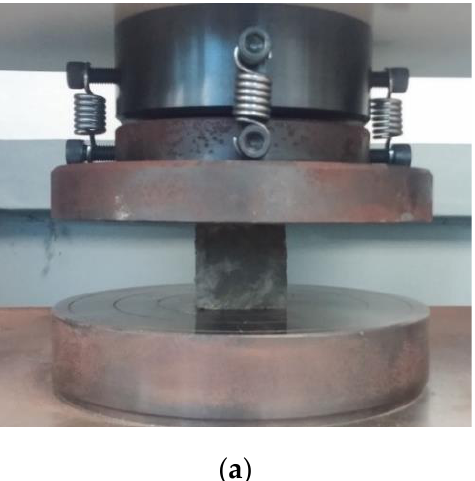
( d ) Figure 1. Slump-flow test: ( a ) ASFC100; ( b ) ASFC125; ( c ) ASFC15 0 ; ( d ) ASFC200.